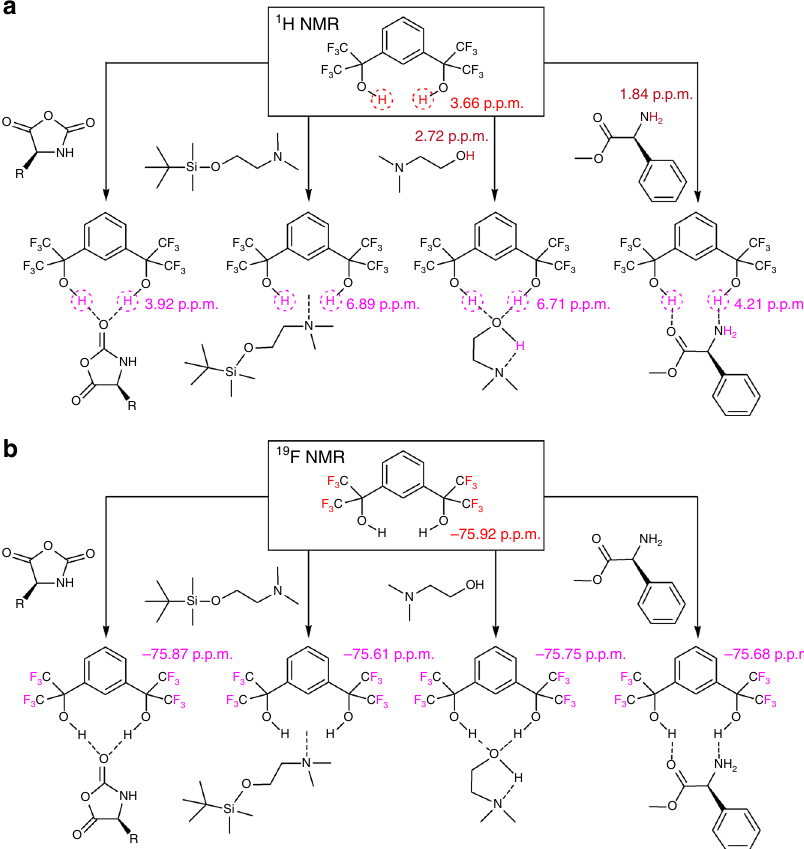
Fig. 5 Chemical shift changes of hydroxyl groups and fl uorine atoms in 1,3-Bis-HFAB. a observed in the NMR spectra of 1,3-Bis-HFAB with Glu-NCA, DMEA-TMS ’ , DMEA, and MAP, respectively; b observed in 19 F NMR spectra (the comparative spectra see supplementary Figs. 2 – 5 and 8) (Source data are provided as a Source Data fi le)